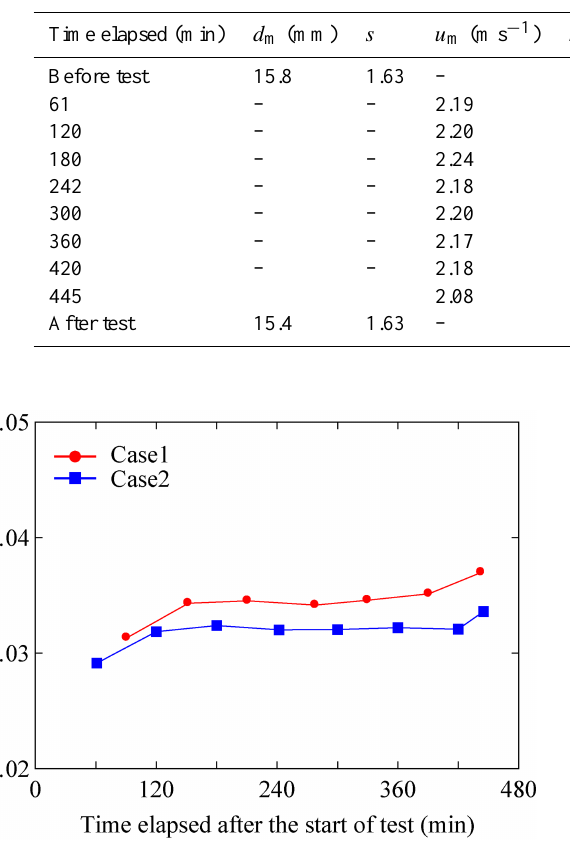
Fig. 6. Time history of Manning’s roughness